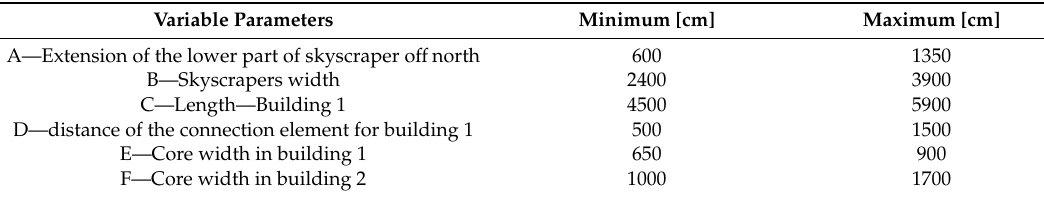
Table 5. Basic variable